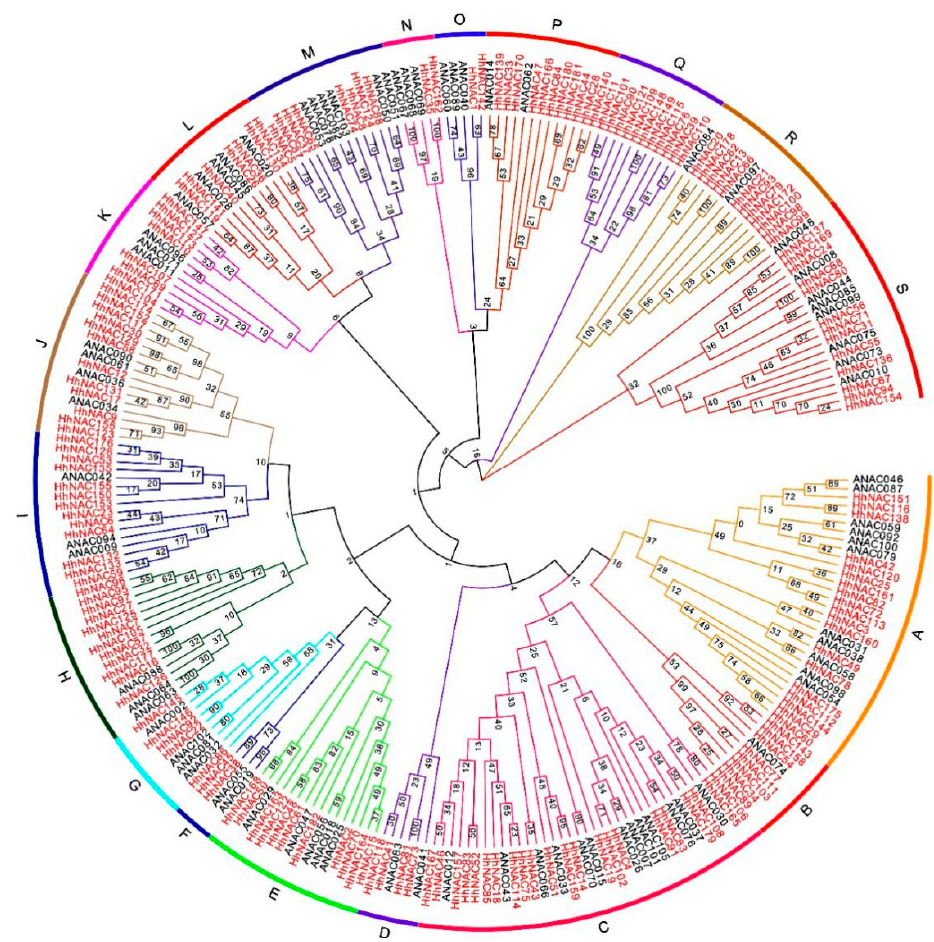
Figure 1. Phylogenetic tree of NAC proteins in A. thaliana and H. hamabo .